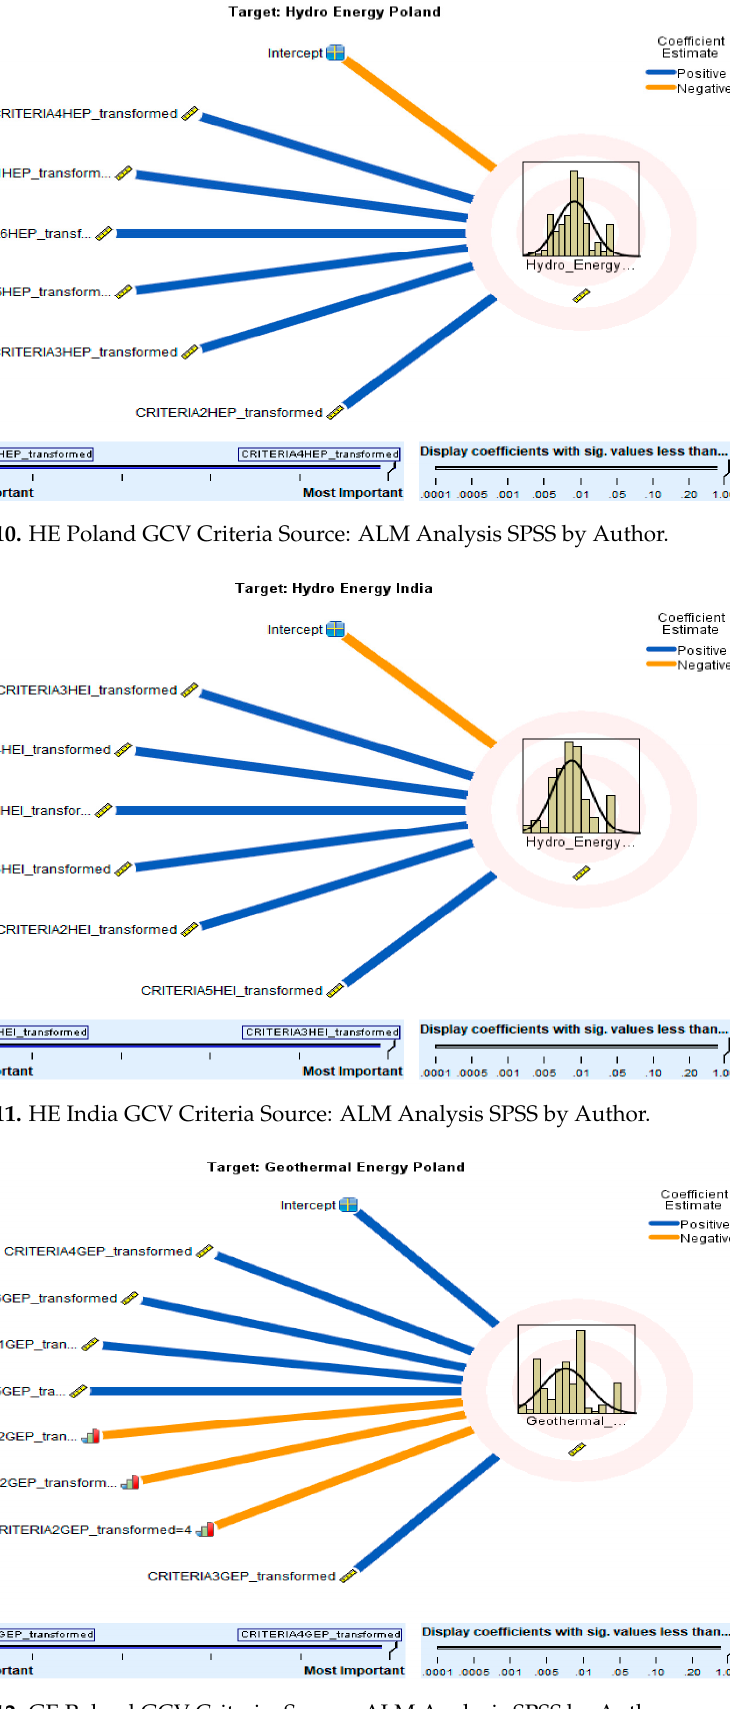
Figure 12. GE Poland GCV Criteria. Source: ALM Analysis SPSS by Author.